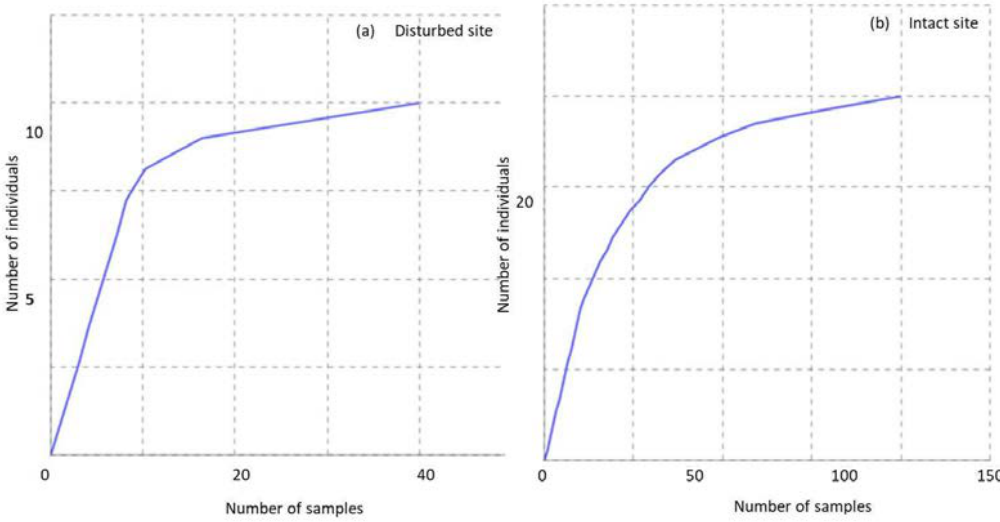
Fig. 5: Rarefaction curves of fish species at disturbed (a) and intact (b) sites on West Java coast